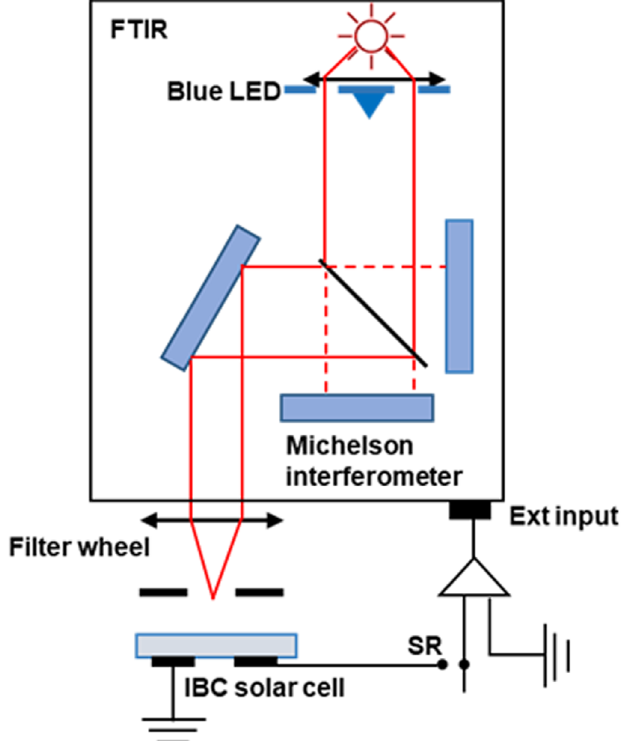
Fig. 2. Schematic of the designed setup for spectral response and quantum ef fi ciency measurements. Light outcoming from FTIR is focused on the IBC cell via an optical fi ber. The cell photocurrent is ampli fi edbythecurrentvoltageconverterandre-injectedasexternal input into the FTIR and transformed to the cell spectra. Note that this setup allows re fl ection-transmission measurements and FTPS- Fourier Transform Photocurrent Spectroscopy